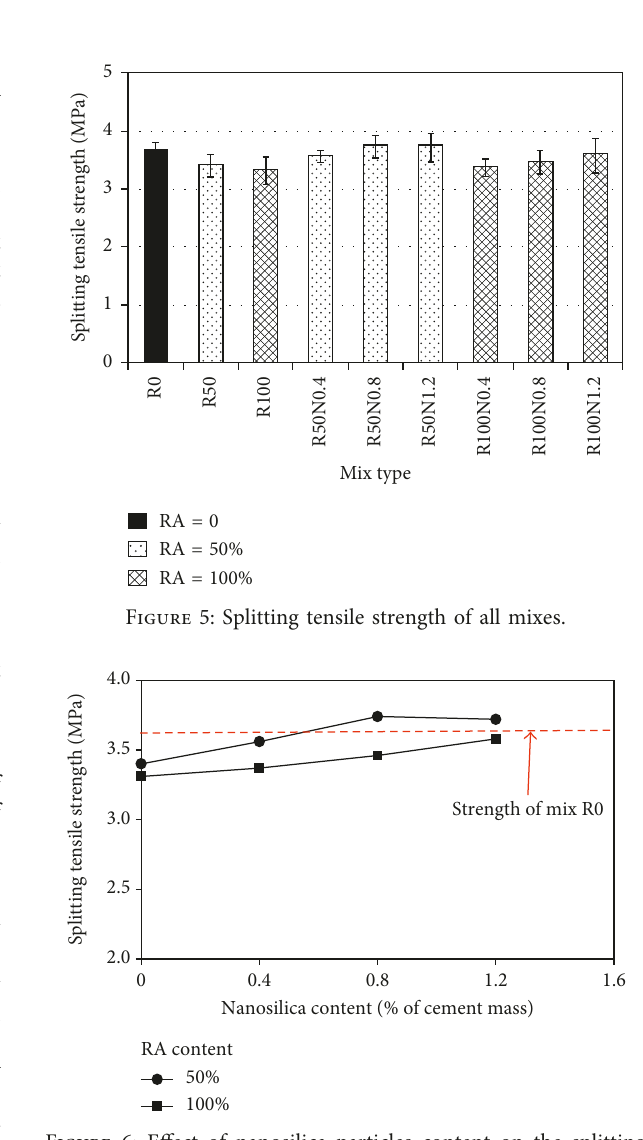
Figure 6: Effect of nanosilica particles content on the splitting tensile strength of RAC